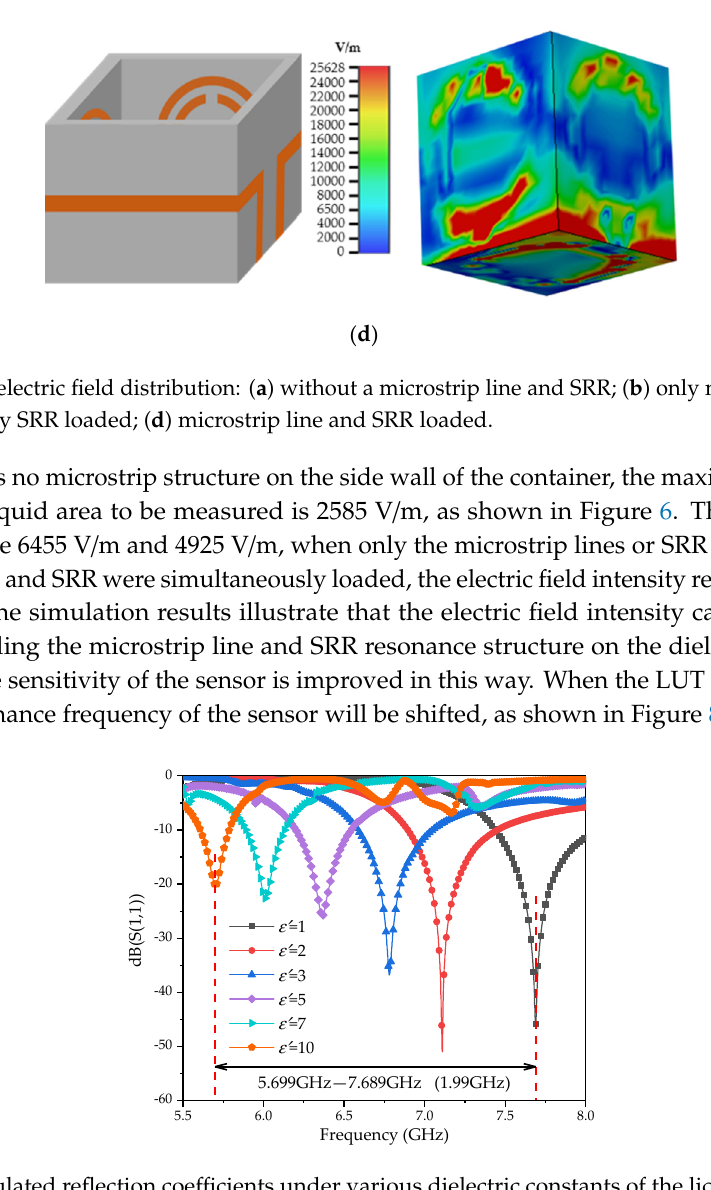
Figure 8. Simulated reflection coefficients under various dielectric constants of the liquid under test (LUT).